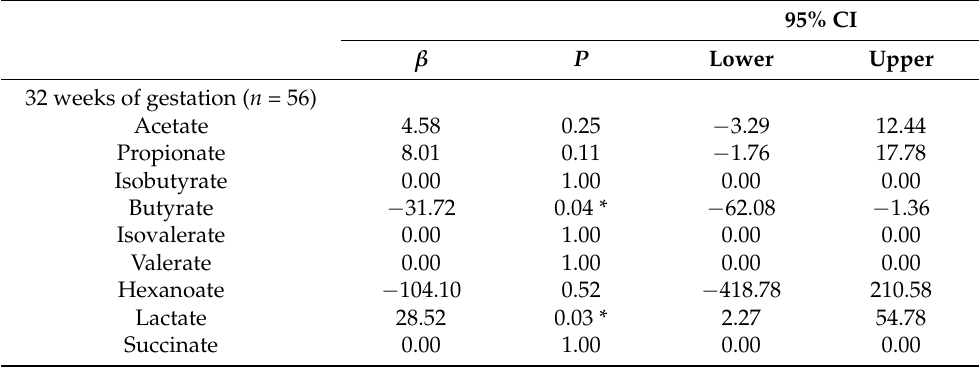
Table 3. Associations between maternal non-specific serum IgE levels at 32 weeks of gestation and short-chain fatty acid levels in maternal feces 1